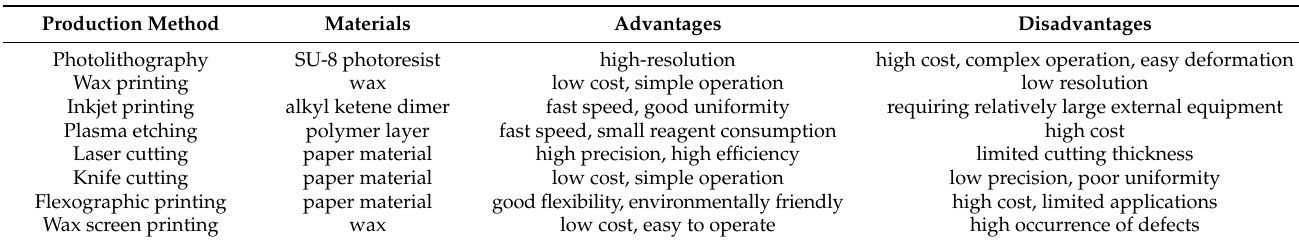
Figure 2. ( a ) Diagram showing the main application field (inner ring) and manufacturing methods (outer ring) of µ PADs. ( b ) Schematic diagram of the three usual processing methods for paper-based microfluidic channels. Principle of photolithography: this melts the photoresist outside the mask into the inner pores of the paper material and forms a physical barrier after re-solidification. Wax printing principle: it is melted by heating the wax material, generating a physical barrier to the void of the paper material in the uncovered area of the mold. Inkjet printing principle: the hydrophilic material is printed on the paper, to form a specific channel after the paper material hydrophobic treatment. Table 1. This table summarizes the processing methods for µ PADs and their main advantages and